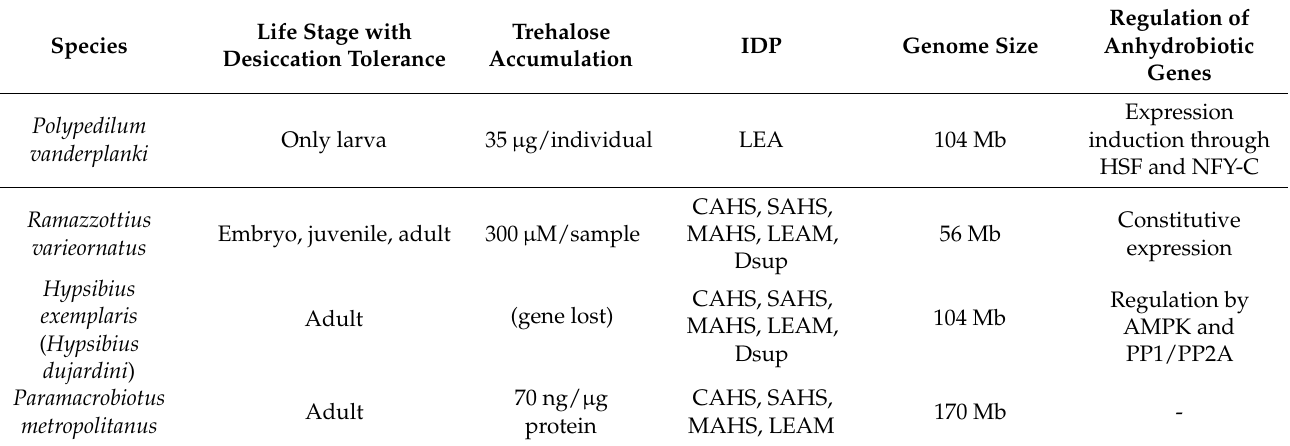
Table 2. Comparison between chironomid and tardigrades showing the current understanding of their anhydrobiotic